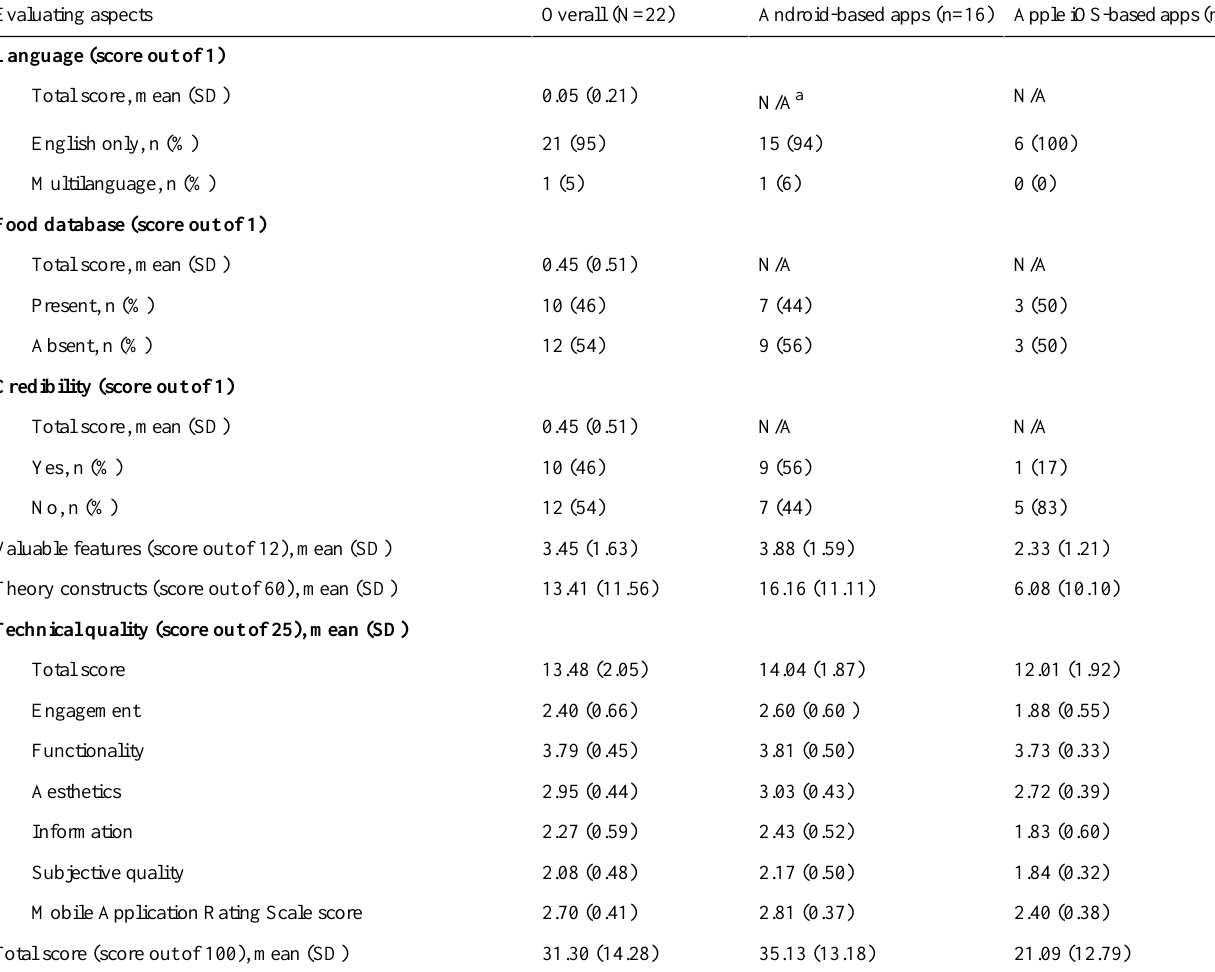
Table 1. Summary scores of the evaluated dialysis diet